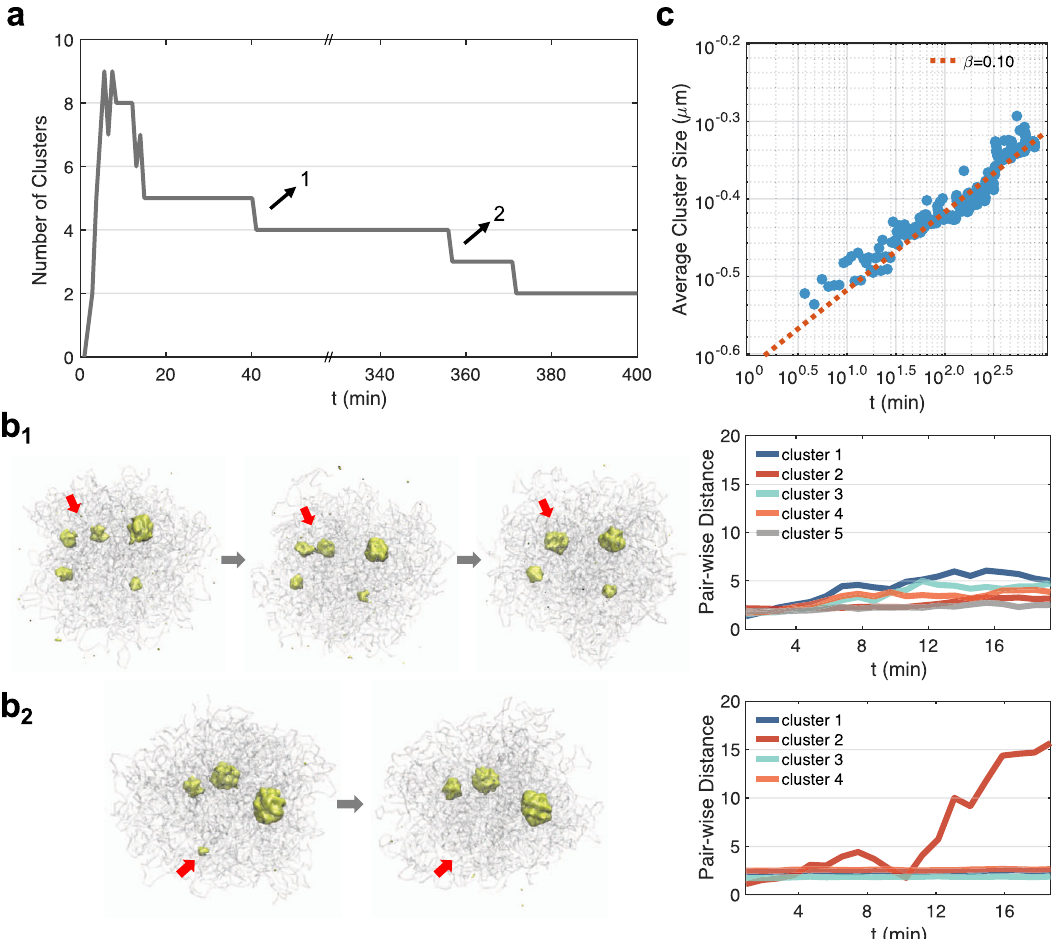
Fig. 5 Coarsening dynamics and pathways for phase separation with the chromatin network. a Time evolution of the number of clusters observed along a dynamical trajectory. b Detailed characterization of the two switching events that follow the Brownian motion-induced coalescence ( b 1 ) and the diffusion- limited Ostwald ripening ( b 2 ) path. The average pair-wise distance for each cluster remains relatively constant along the fi rst path but increases signi fi cantly along the second one due to particle evaporation. c Power-law scaling of the average cluster size as a function of